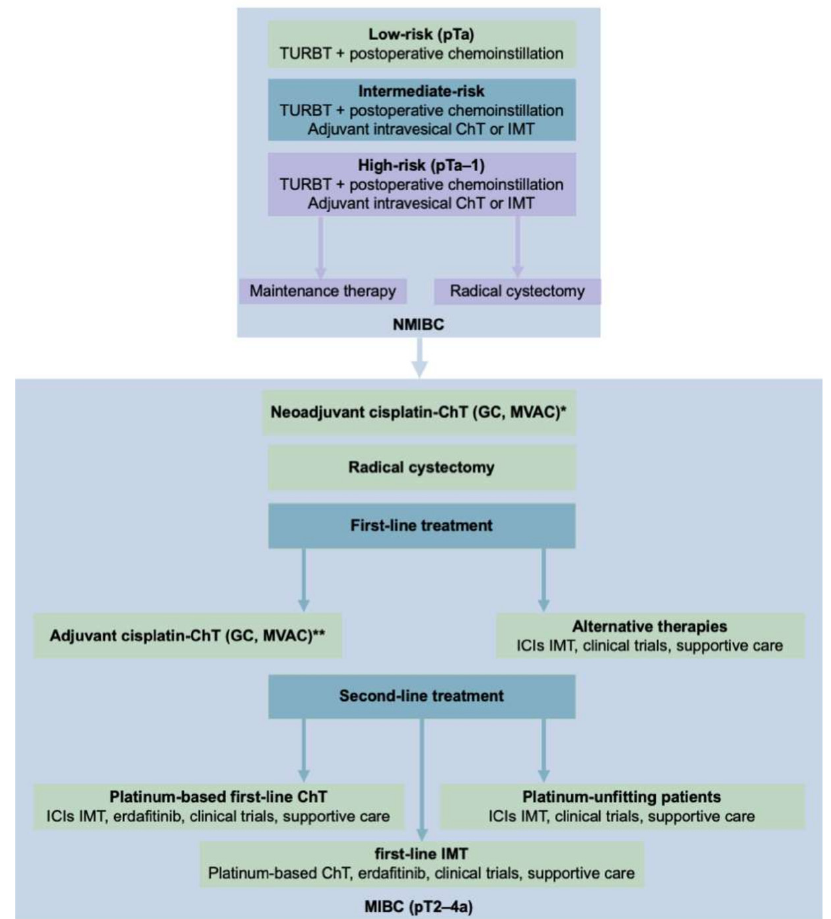
Figure 10. Schematic representation of the therapeutical management algorithm for bladder can- cer. TURBT: transurethral resection of bladder tumor; ChT: chemotherapy; IMT: immunotherapy; GC: gemcitabine/cisplatin; MVAC: methotrexate/vinblastine/doxorubicin/cisplatin; NMIBC: non- muscle-invasive bladder cancer; MIBC: muscle-invasive bladder cancer; ICIs: immune checkpoint inhibitors. *: optative for platinum-based ChT fitting-patients. **: offered if no neoadjuvant ChT